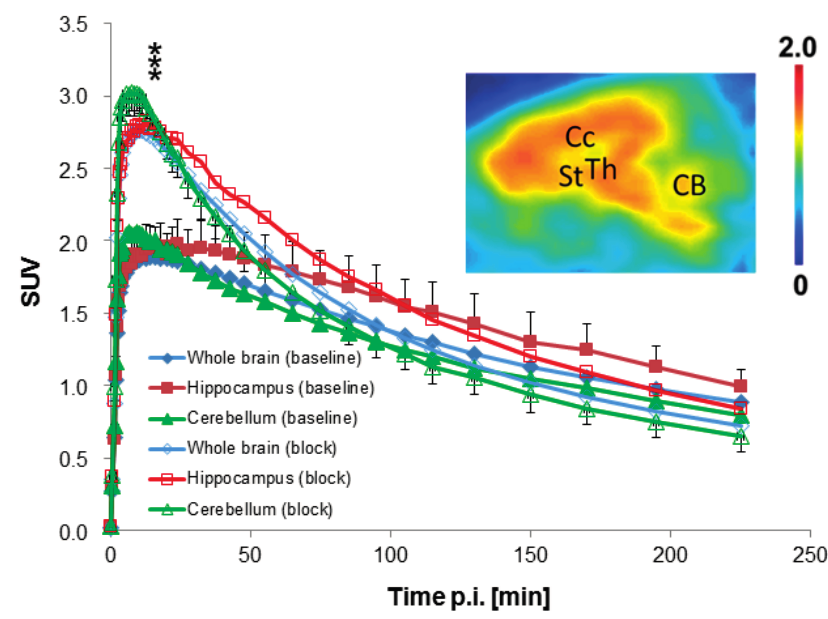
Figure 3. Time-activity curves in different brain regions obtained by dynamic PET scans of [ 18 F] 10a in piglets under baseline and blocking conditions (mean values; n = 3). Standard deviations are shown for two examples (hippocampus baseline and cerebellum block). *** p < 0.001 vs. baseline. Inset: Brain image in sagittal plane acquired from 0 to 20 min p.i. after injection of [ 18 F] 10a in a female piglet. Data are expressed as